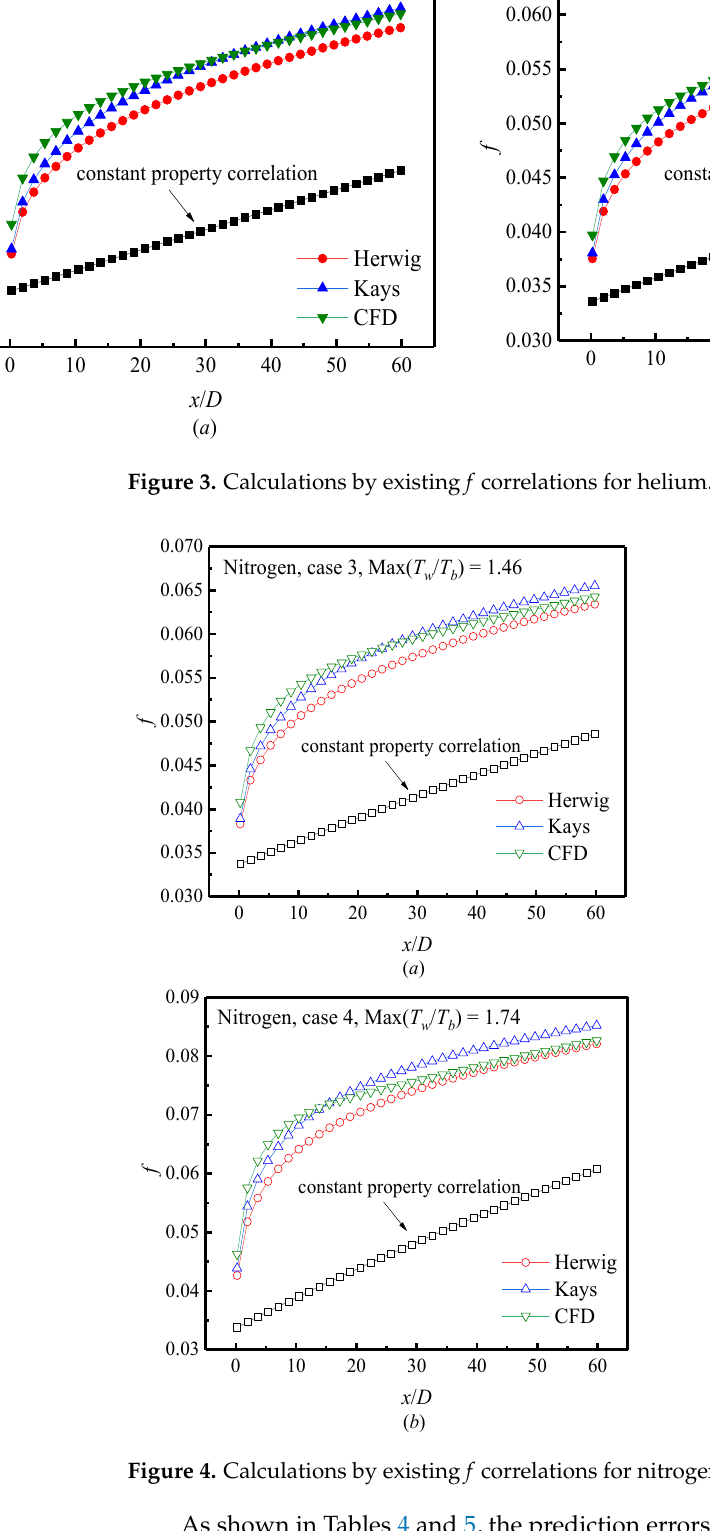
0.7% Table 5. Calculation errors of nitrogen by laminar flow f correlations. Δ x / D